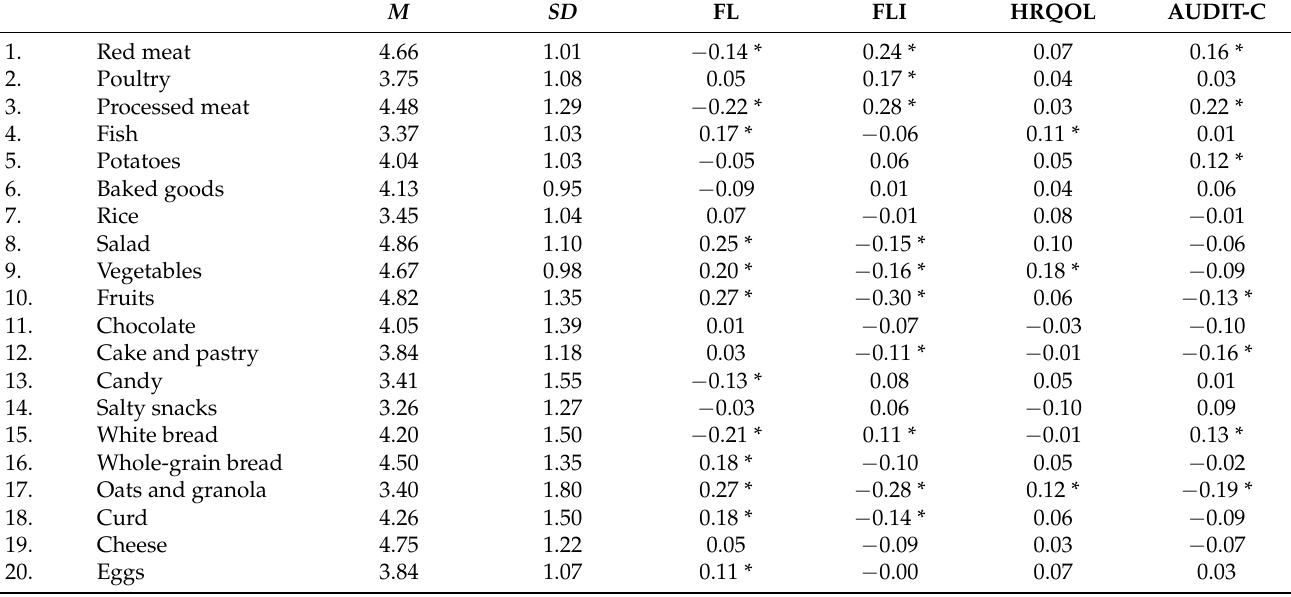
Table A1. Means, SD s, and bivariate correlations for the food groups listed and FL, FLI, HRQOL, and alcohol